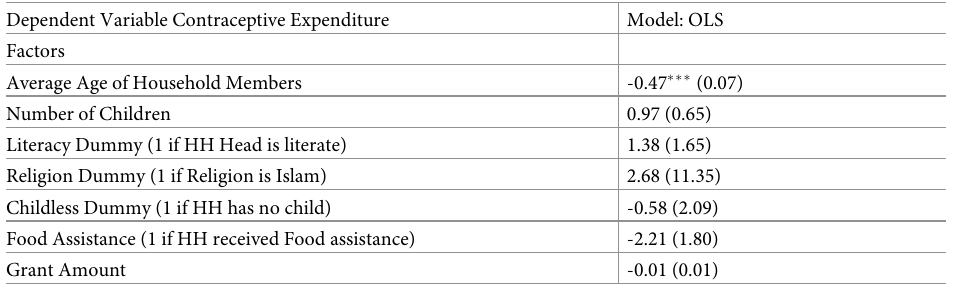
Table 4. Factors associated with contraceptive